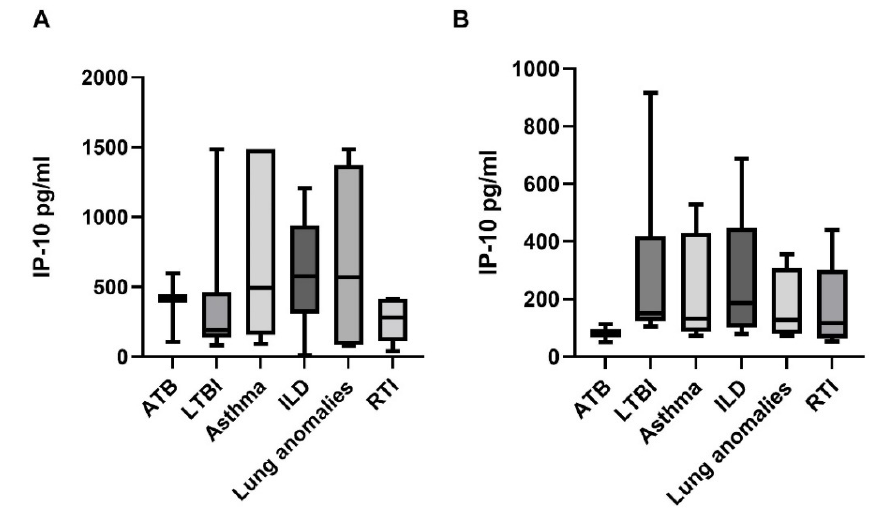
Figure 2. IP-10 responses in bronchoalveolar lavage fluid ( A ) and plasma ( B ) in the study groups.